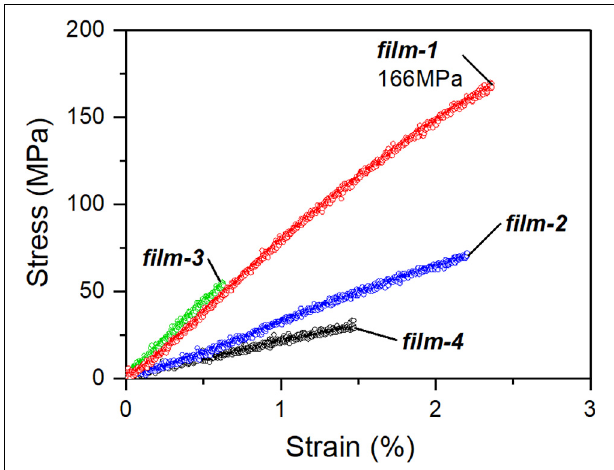
FIGURE 2 | Tensile stress-strain curves of the CNT